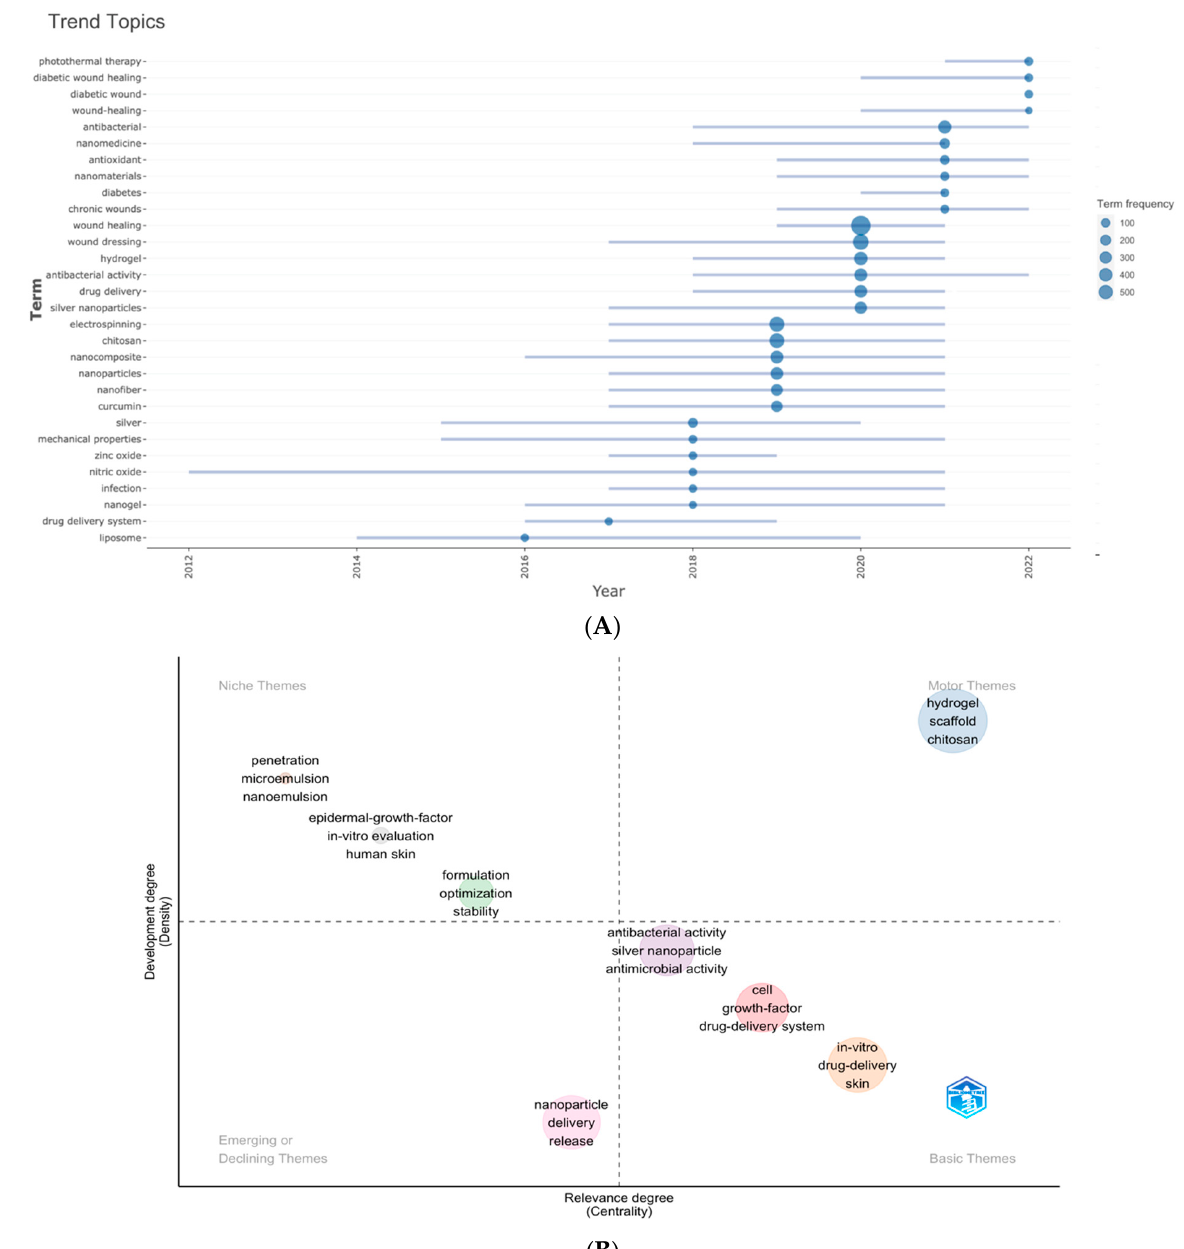
Figure 10. ( A ) Trend topics. The X -axis represents the year, while the Y -axis represents the cumulative keyword occurrences. ( B ) The keywords thematic map generated by R-Bibliometrix. The X -axis represents the centrality indicating the importance of a theme; The Y -axis symbolizes the density indicating the development of a theme.